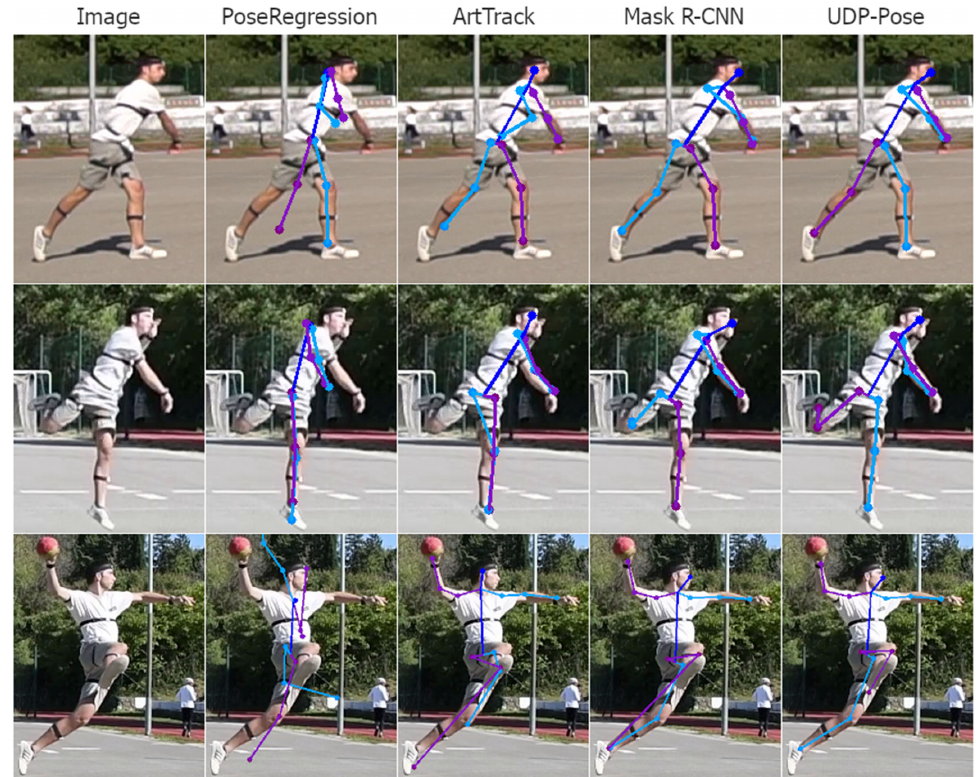
Figure 18. Examples of poor detection of keypoint location that happens mostly because the true keypoint location is occluded or less clear. The right side of the player is coloured purple while the left side of the person is coloured blue. In the first row, where the left elbow and hand are not visible, methods PoseRegression and ArtTrack incorrectly assume the location, while Mask R-CNN and UDP-Pose placed the left elbow and hand on the right elbow and hand of the player. The second row shows a situation where parts are visible but less clear, where all methods fail to detect the left hand, which is close to the head, while methods ArtTrack and Mask R-CNN miss the right foot. The third row shows situations where methods ArtTrack and Mask R-CNN produced invalid human structures by detecting the right foot on the location of the left foot, while the UDP-Pose almost correctly detected the keypoints. PoseRegression generally did not perform well on uncommon poses such as the handball jump-shot.